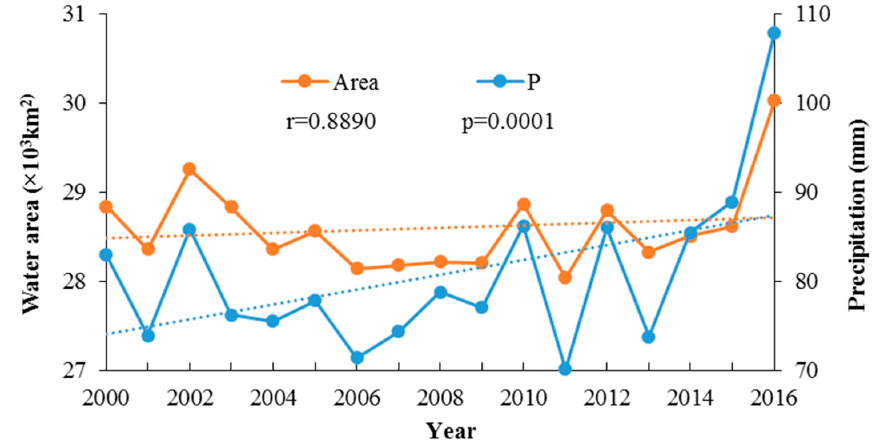
Figure 14. Correlation between annual average water areas and annual precipitation for YRB from 2000 to 2016.